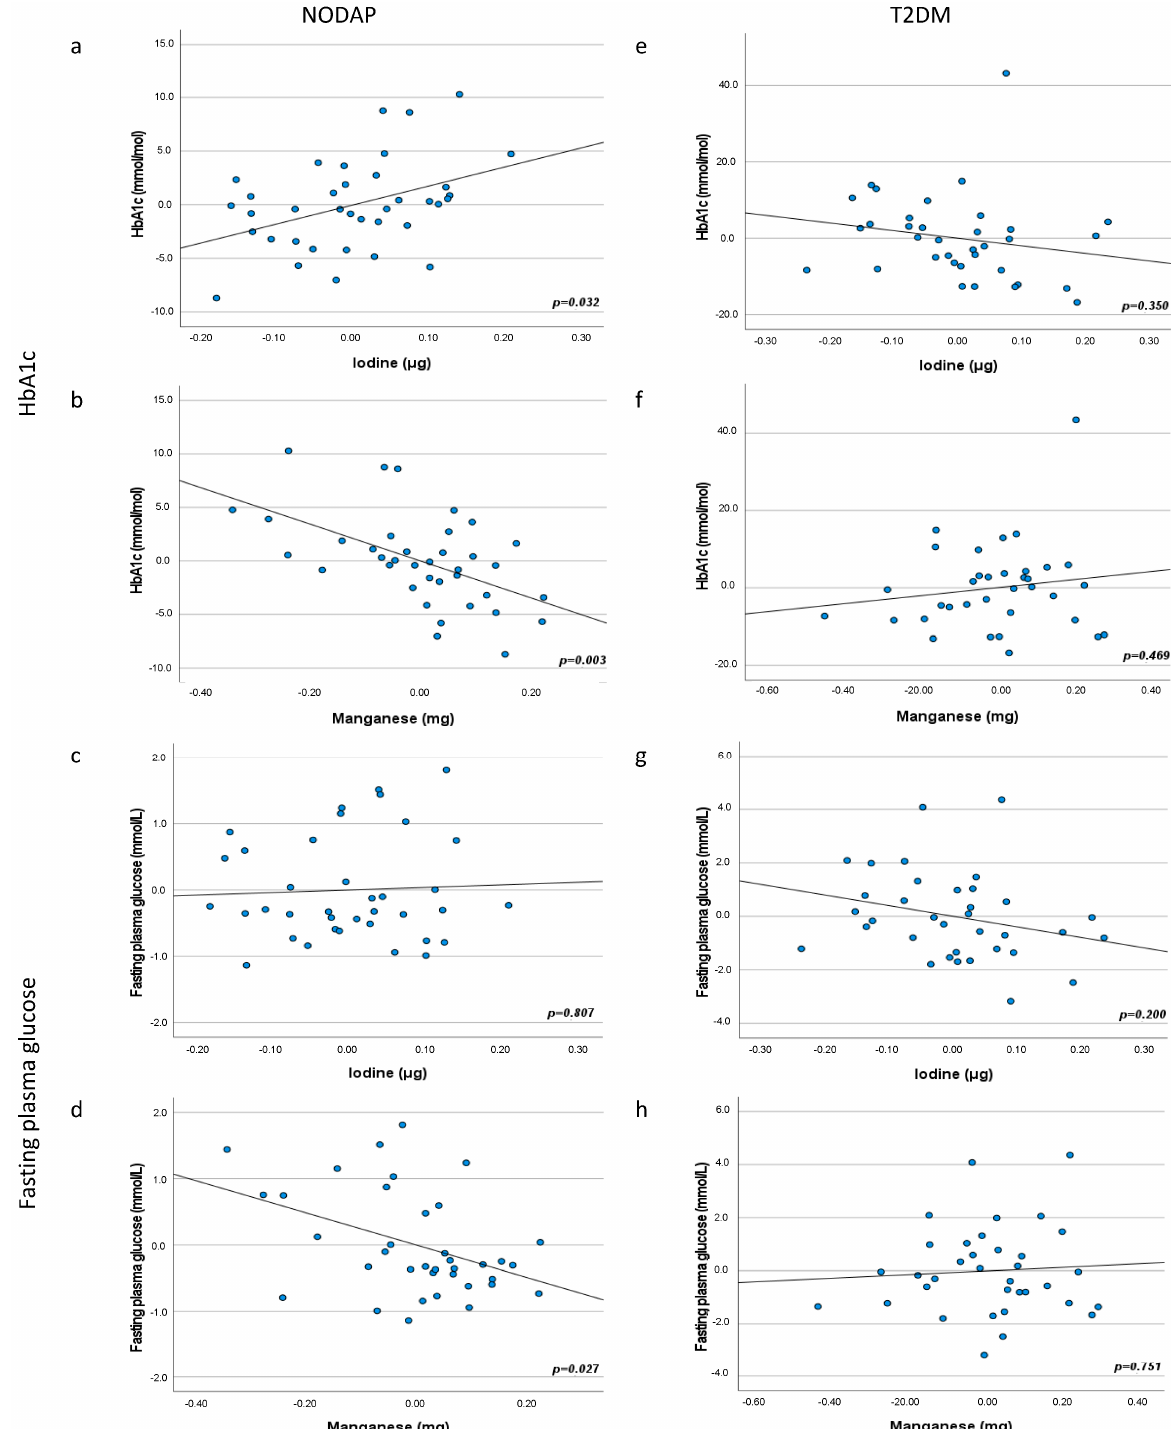
Figure 1. Associations between iodine and manganese intake and markers of glucose metabolism in NODAP ( a–d ) and T2DM ( e–h ). Abbreviations: NODAP = New-onset diabetes or prediabetes after acute pancreatitis. T2DM = Type 2 diabetes or prediabetes prior to acute pancreatitis. HbA1c = glycated haemoglobin. Iodine and manganese data were log transformed. Partial regression plots were adjusted for age, sex, daily energy intake, V/S fat volume, alcohol intake, smoking status, aetiology of AP, number of AP episodes, cholecystectomy, use of antidiabetic medications. Significance was set at p < 0.05.